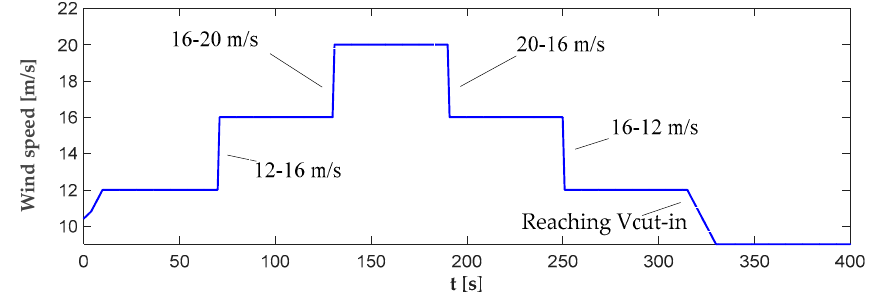
Figure 9. Five types of short-term interval wind fluctuations.